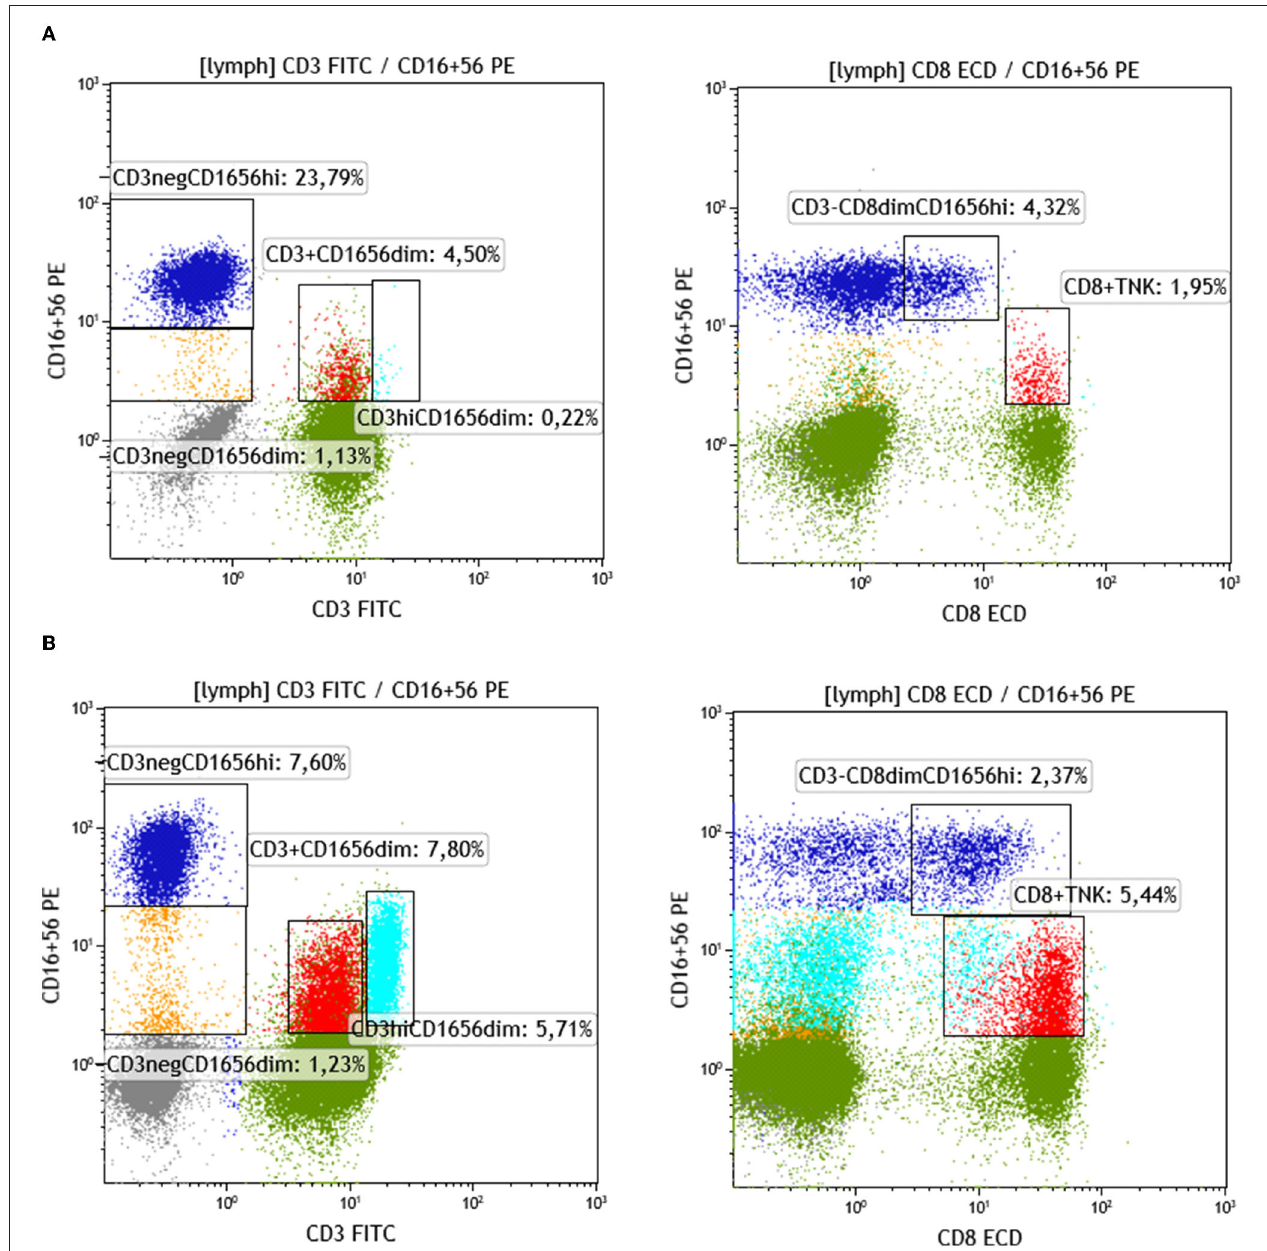
FIGURE 6 | Identification and quantification of NK and NKT in patients with a different allelic burden. (A) Patient with no chimeric alleles detected. (B) Patient with three chimeric alleles detected (splenectomized) (green: CD3 + non-NK, gray: CD3– non-NK, blue: NK CD56CD16 br , red: CD8 + NKT, turquoise: CD3 br T/NK yellow: NK CD56CD16 dim